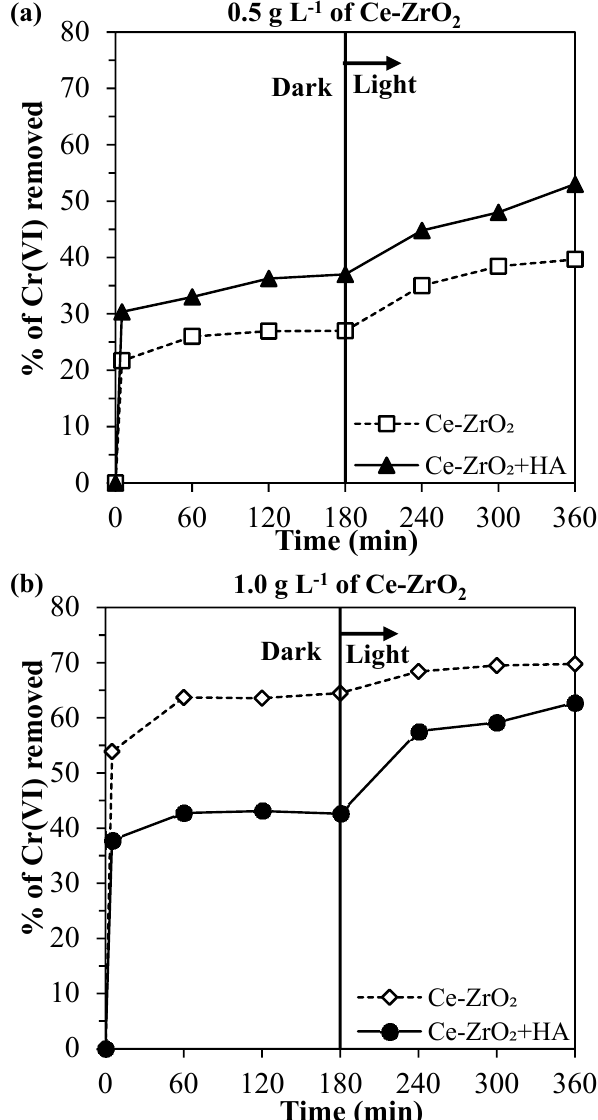
Figure 4. Cr(VI) removed at an initial pH of 4, without humic acid (HA) and with 10 mg L − 1 of HA, in the experiments using: ( a ) 0.5 g L − 1 of Ce–ZrO 2 and ( b ) 1.0 g L − 1 of Ce–ZrO 2 .